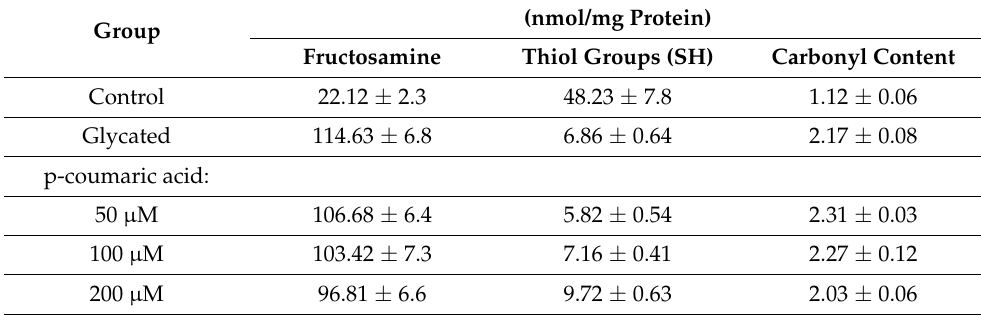
Table 4. Effect of different concentrations of p-coumaric acid on alpha